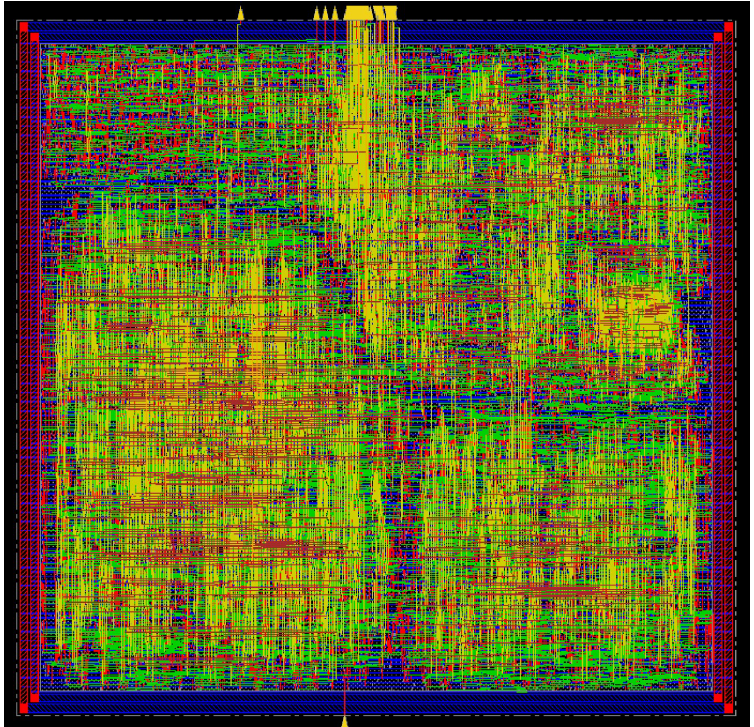
Figure 11. Layout of the implemented WVSN sensor